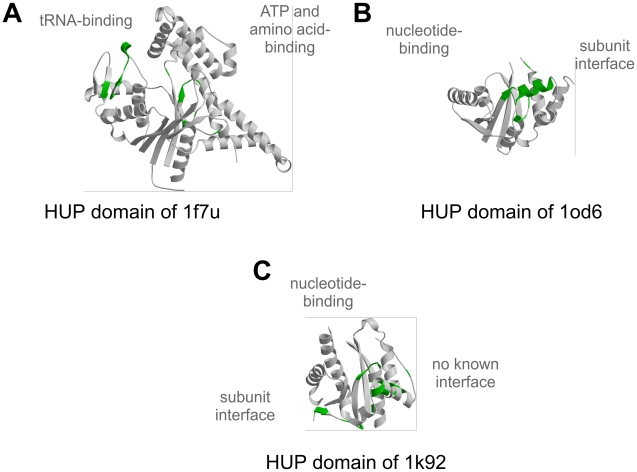
Representatives from the Tyrosyl-Transfer RNA Synthetase superfamily (3.40.50.620) in CATH.A 1f7u, B 1od6, C 1k92. FLORA residues are shown in green.